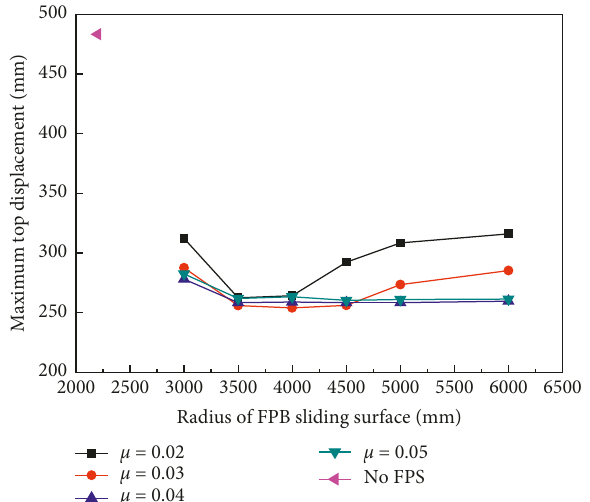
Figure 24: The maximum drift of T4S tower with R d direction under L0223S wave.